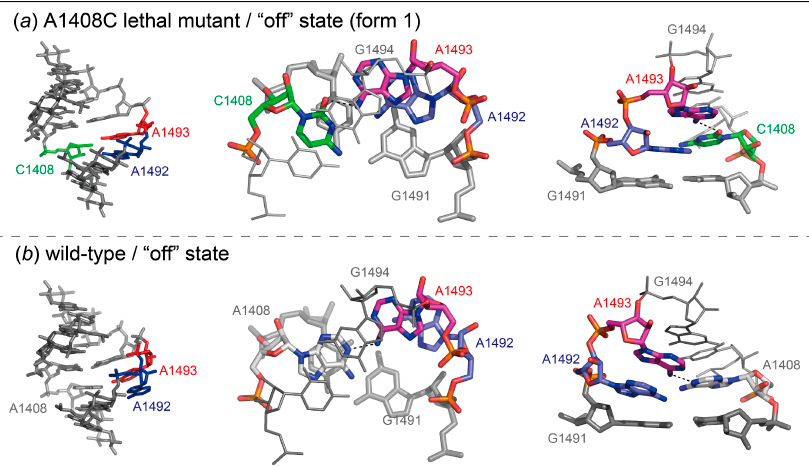
Figure 3. Molecular structures (left) and close-up views of base pairs (center) and stacking interactions (right) observed in the “off” state form 1 of the bacterial A1408C lethal mutant ( a ) and wild type (28: PDB-ID = 3BNL) ( b ) A sites.